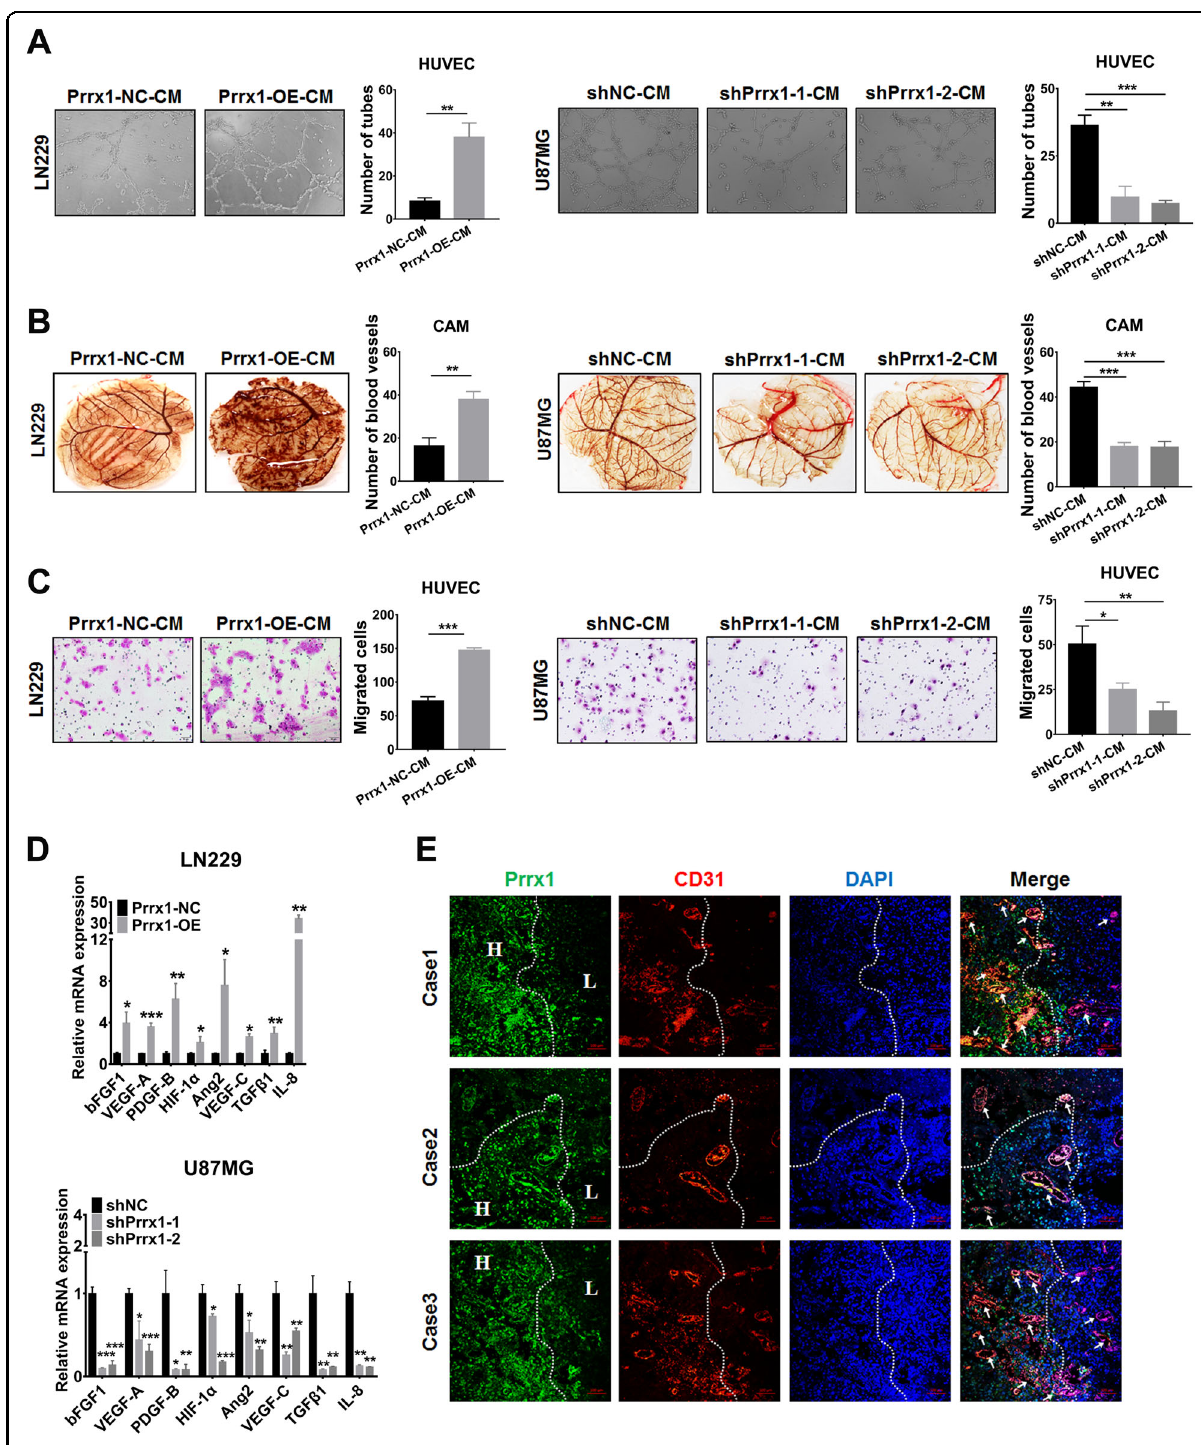
Fig. 3 Prrx1 promotes glioma angiogenesis through upregulating proangiogenic factors in NSTCs. A Representative capillary tubule structures were shown for HUVECs treated with culture medium collected from the indicated LN229 and U87MG cells. Scale bar represents 50 μ m. B Blood vessels formed in representative images of the CAM assay after CM treatment. C Transwell assay was performed in HUVECs to detect the effect of CM treatment on cell migration. Scale bar represents 50 μ m. D RT-qPCR detects the effects of Prrx1 on the expression of classical proangiogenic factors in U87MG and LN229 cells (mean± SD, n = 3). E IF assay analysis of glioma specimens showed the vessel density in regions with different Prrx1 expression levels. The H indicated regions with high expression level of Prrx1 and the L indicated regions with low Prrx1 expression. Representative images of three cases were shown. Scale bar represents 10 μ m. * P < 0.05, ** P < 0.01, *** P <